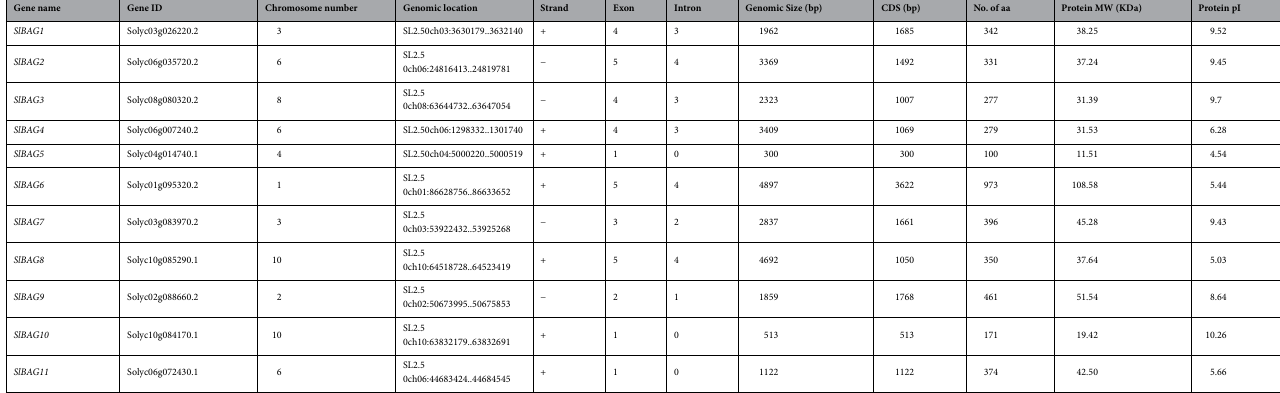
Table 1. Identification, chromosome location and properties of tomato BAG domain-containing